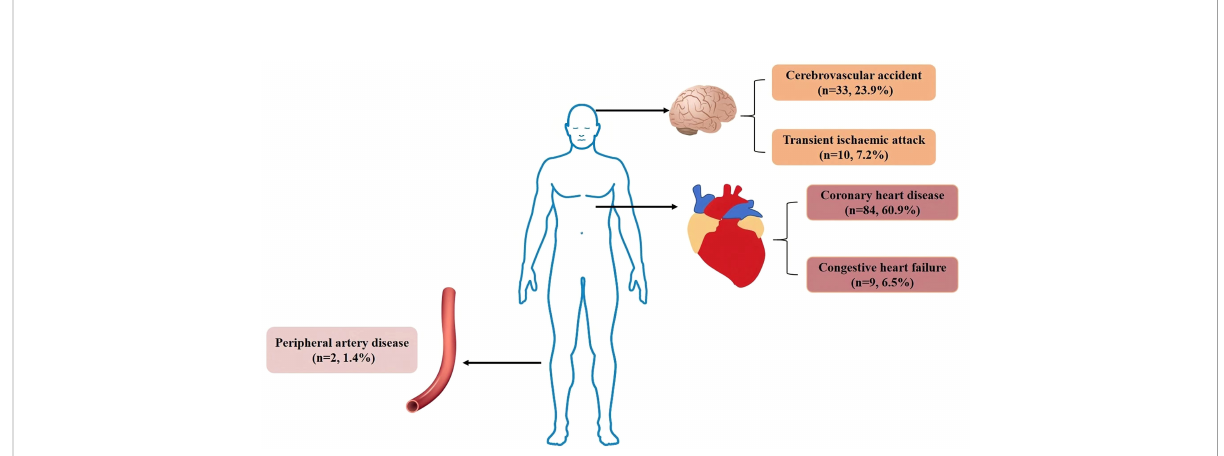
FIGURE 2 Classi fi cation of CVD events. Legend: In our cohort, there were 138 CVD events, 84 patients with coronary heart disease, 9 patients with congestive heart failure, 33 patients with cerebrovascular accident, 10 patients with transient ischaemic attack and 2 patients with peripheral arterial disease. CVD, Cardiovascular